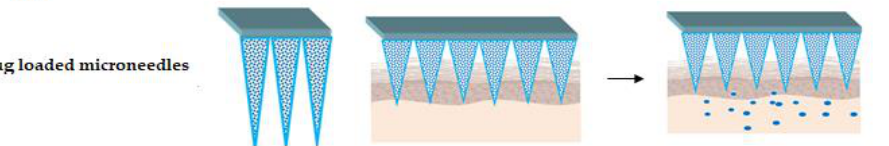
Figure 2. Strategies for drug delivery using MNs ( a ) “Poke and Patch” Strategy ( b ) “Coat and Poke” Strategy ( c ) “Poke and Release” Strategy [30,56–58] ( d ) “Poke and Flow” Strategy.